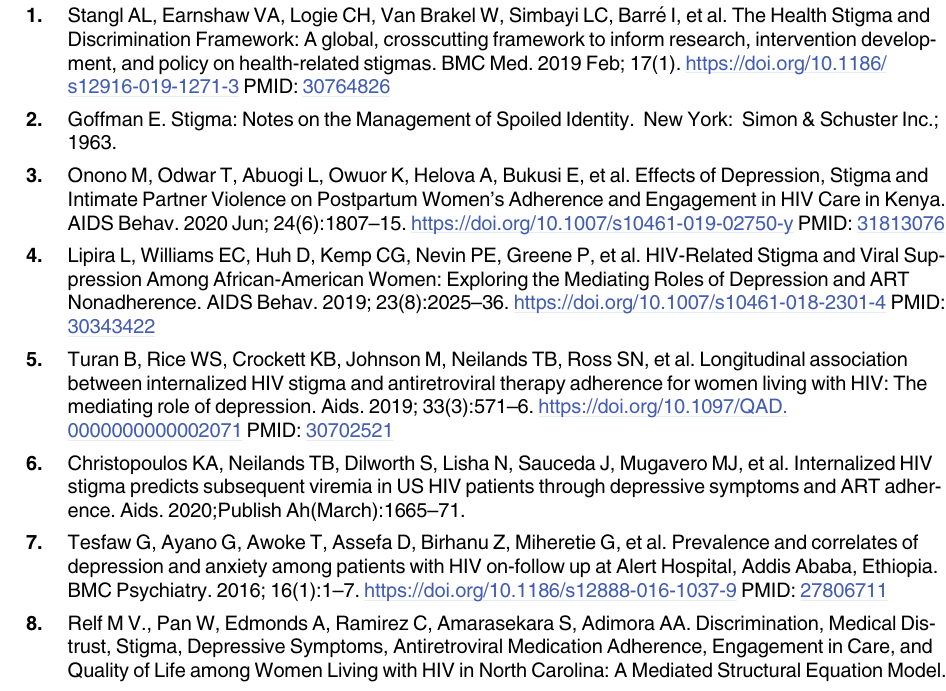
S1 Table. Sample search